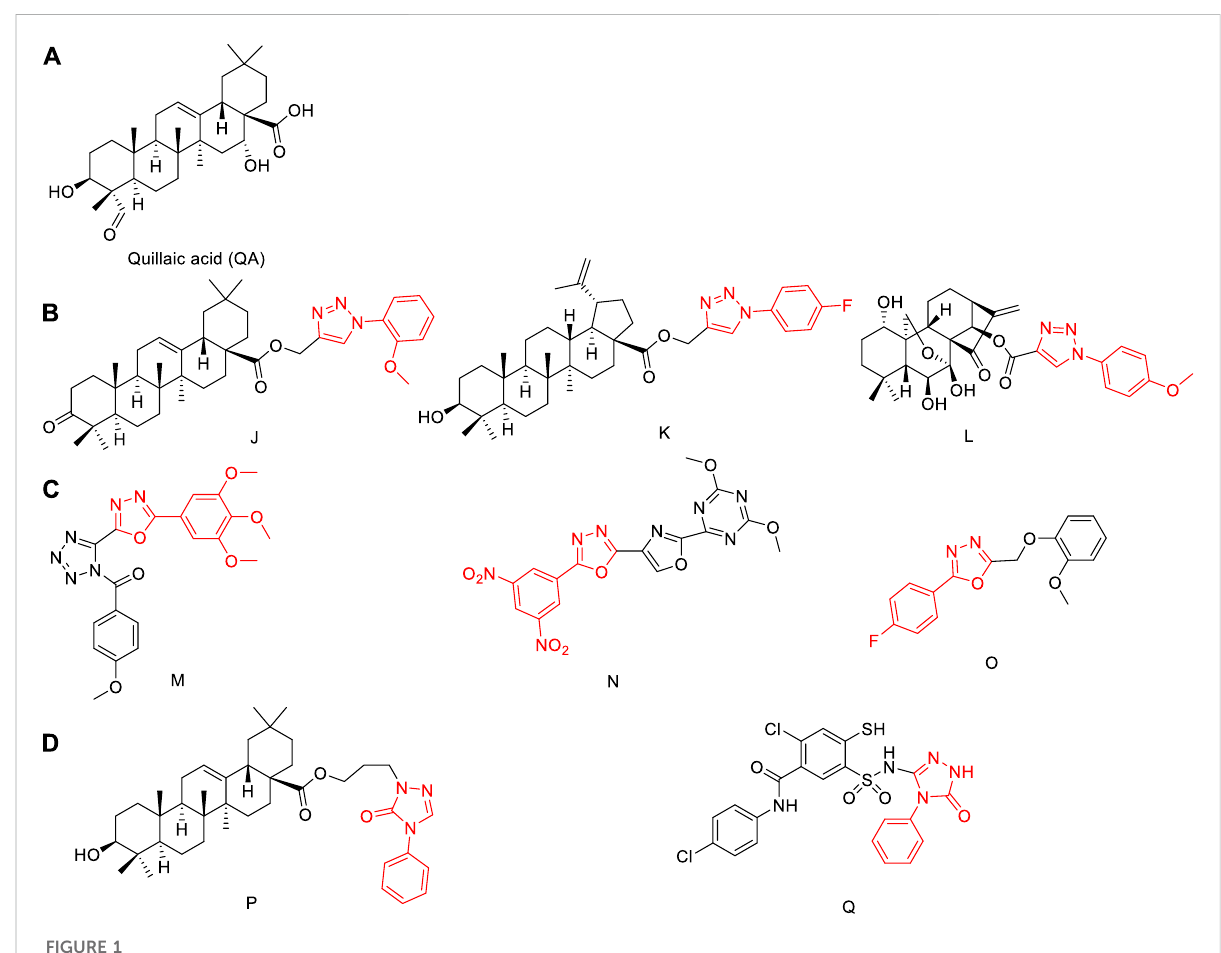
FIGURE 1 (A) Structures of quillaic acid. (B) Structures of natural-product derivatives containing phenyl-1,2,3-triazole; (C) Structures of compounds containing phenyl-1,3,4-oxadiazole; (D) Structures of compounds containing